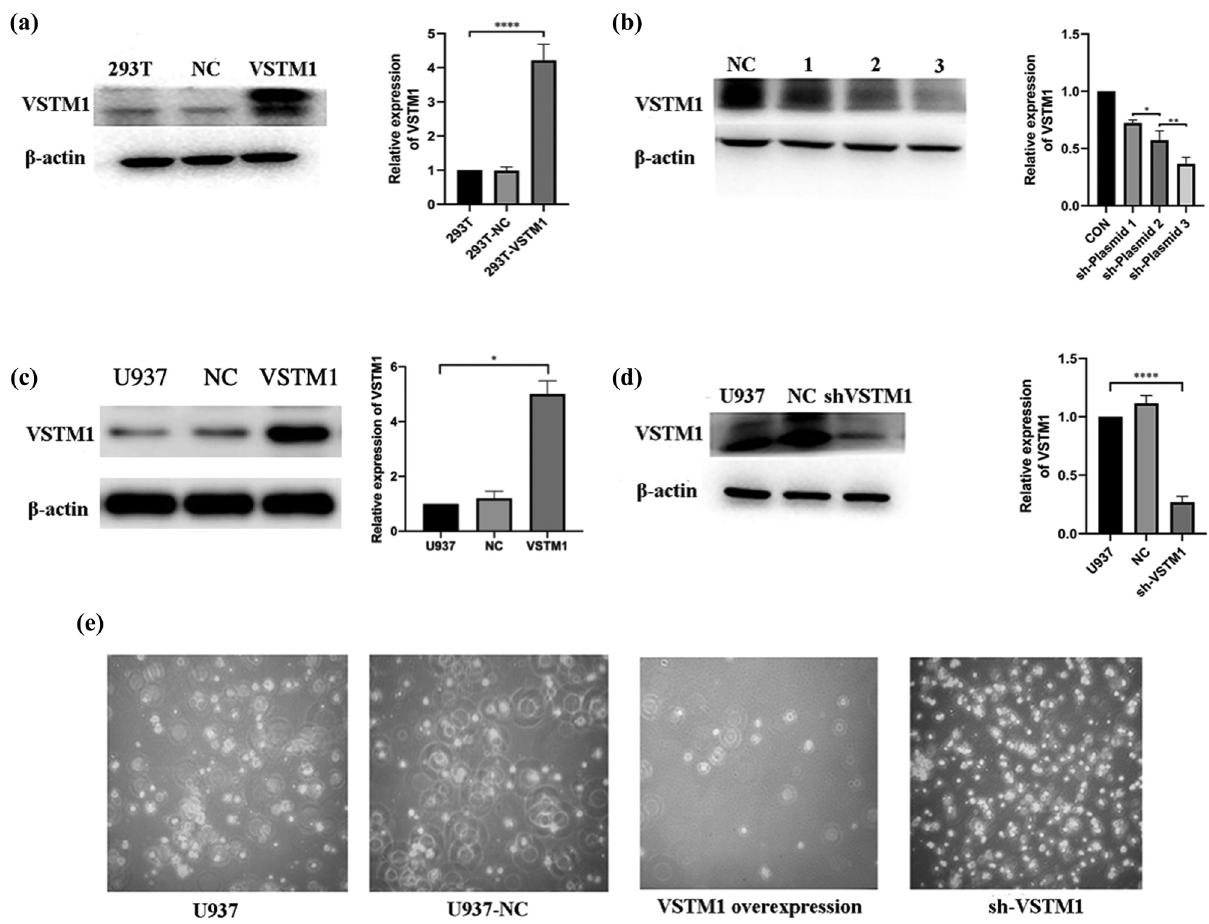
Figure 1: Plasmid construction and identi fi cation of transfection e ffi ciency. ( a ) VSTM1 overexpression plasmid was transfected into 293 T cells successfully ( NC as control plasmid ) , and the expression of VSTM1 at the protein level was evaluated by Western blotting analysis ( compared with the 293 T group, * p < 0.05, ** p < 0.01, *** p < 0.001, **** p < 0.0001, n = 3 ) . ( b ) Three types of VSTM1 interference plasmids were transfected into 293 T cells. The transfection e ffi ciency was compared between them ( Con as control plasmid, 1, 2, 3 as plasmid number, compared with the plasmid 2 group, * p < 0.05, ** p < 0.01, *** p < 0.001, **** p < 0.0001, n = 3 ) . ( c ) Evaluation of transfection e ffi ciency of VSTM1 overexpression stable cell lines ( NC as control plasmid ) , and the expression of VSTM1 at the protein level was evaluated by Western blotting analysis ( compared with the 293 T group, * p < 0.05, ** p < 0.01, *** p < 0.001, **** p < 0.0001, n = 3 ) . ( d ) Evaluation of transfection e ffi ciency of VSTM1 interference stable cell lines ( NC as control plasmid ) , and the expression of VSTM1 at the protein level was evaluated by Western blotting analysis ( compared with the 293 T group, * p < 0.05, ** p < 0.01, *** p < 0.001, **** p < 0.0001, n = 3 ) . ( e ) VSTM1 overexpression stable strains grew very slowly. Therefore, only the interference group was used in the subsequent experiment. Statistical analysis was performed using Pearson chi - square test or Fisher ’ s exact test ( n < 5 ) with subsequent multiple comparisons using chi - square with Bonferroni correction for categorical variables. One - way ANOVA with subsequent post hoc multiple comparisons was used for continuous variables with the Student – Newman – Keuls